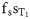
Stock and flow diagram of the basic HIV-1 dynamics model, modified from Rong et al [35].Uninfected CD4+ T cells (T1) are produced at a rate fssT1. Infected CD4+ T cells are produced at a rate kT1VT1, following mass-action kinetics between free virions (V) and uninfected CD4+ T cells. A small fraction αL of infections results in latently infected resting CD4+ T cells (L). The remaining fraction results in productively infected activated CD4+ T cells (T2). Latently infected CD4+ T cells are activated into productively infected cells at a constant rate aL. Free virions are produced by productively infected CD4+ T cells at a rate fppvT2.